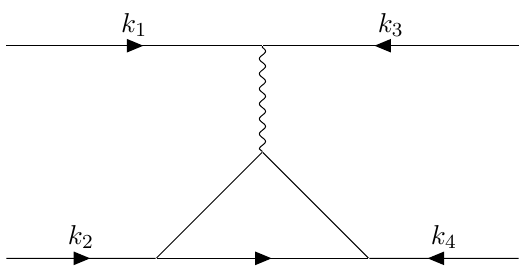
Figure 4 . Feynman diagram representation for one-loop scalar scattering with two dilaton ex- changes. The solid lines represent scalar states and the wavy lines represent gravitons. Note that the internal solid lines represent massless dilaton